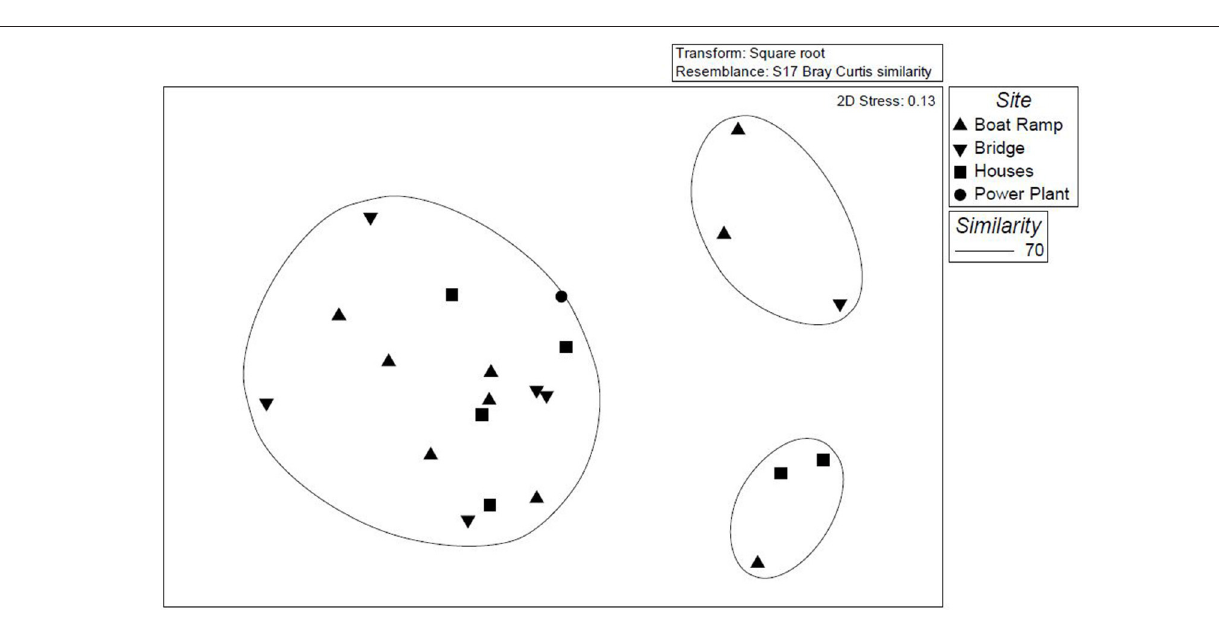
seasons collected from the study sites boat ramp, residential site and the site near the bridge. Cluster analysis did not show any site or month-specific domination of particular diatom groups or species. The differences in TRF patterns were not specific to the study sites and the study months, while these differences might be caused due to other environmental